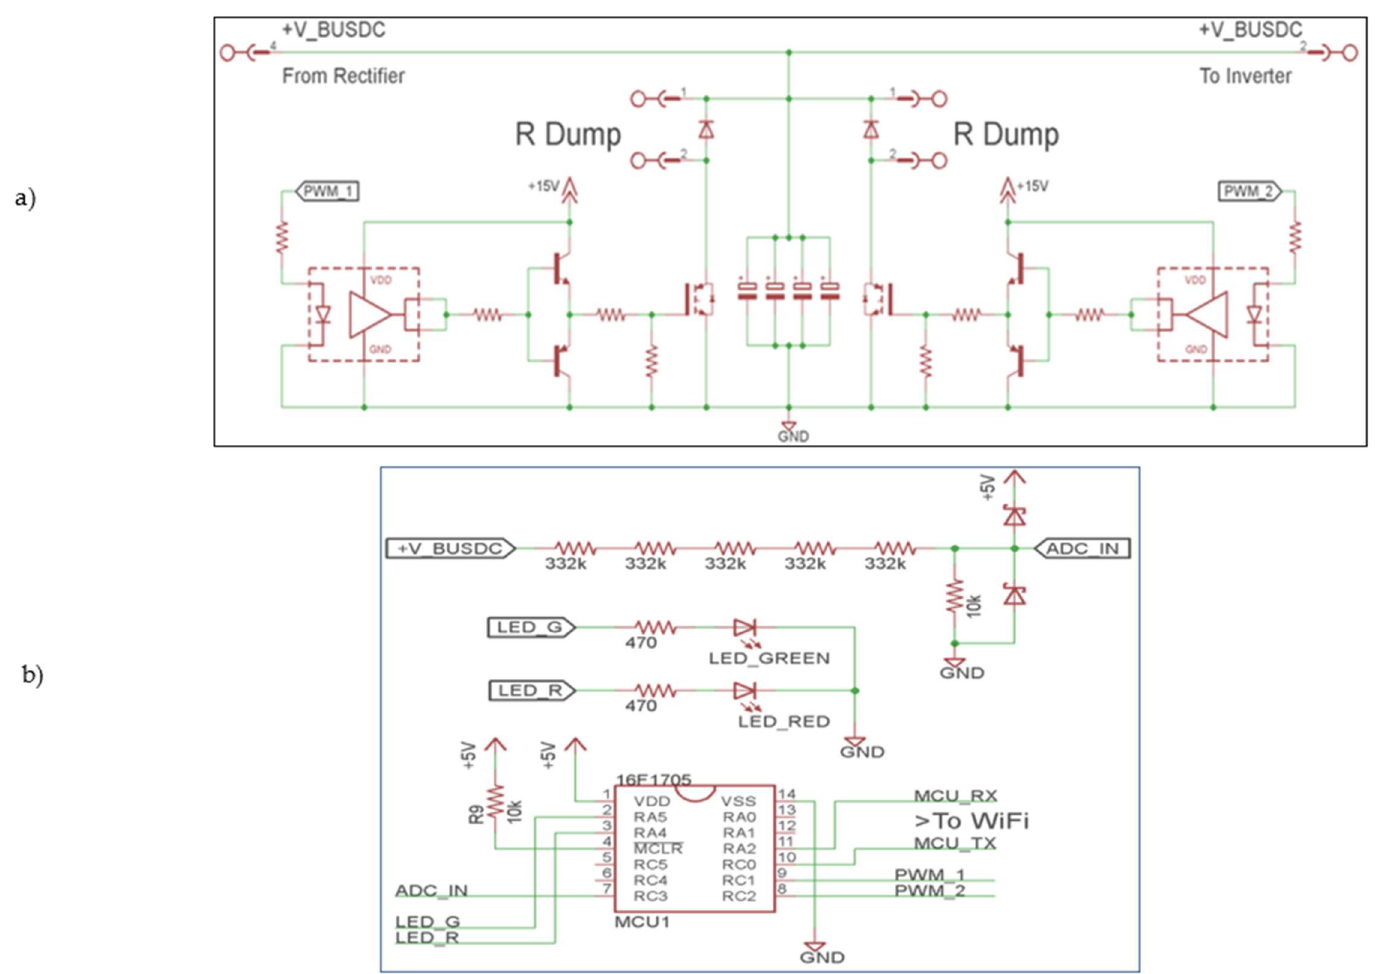
Figure 16. ( a ) Circuit diagram of driver and power chopper, ( b ) circuit diagram of microcontroller with WiFi board and measurement.